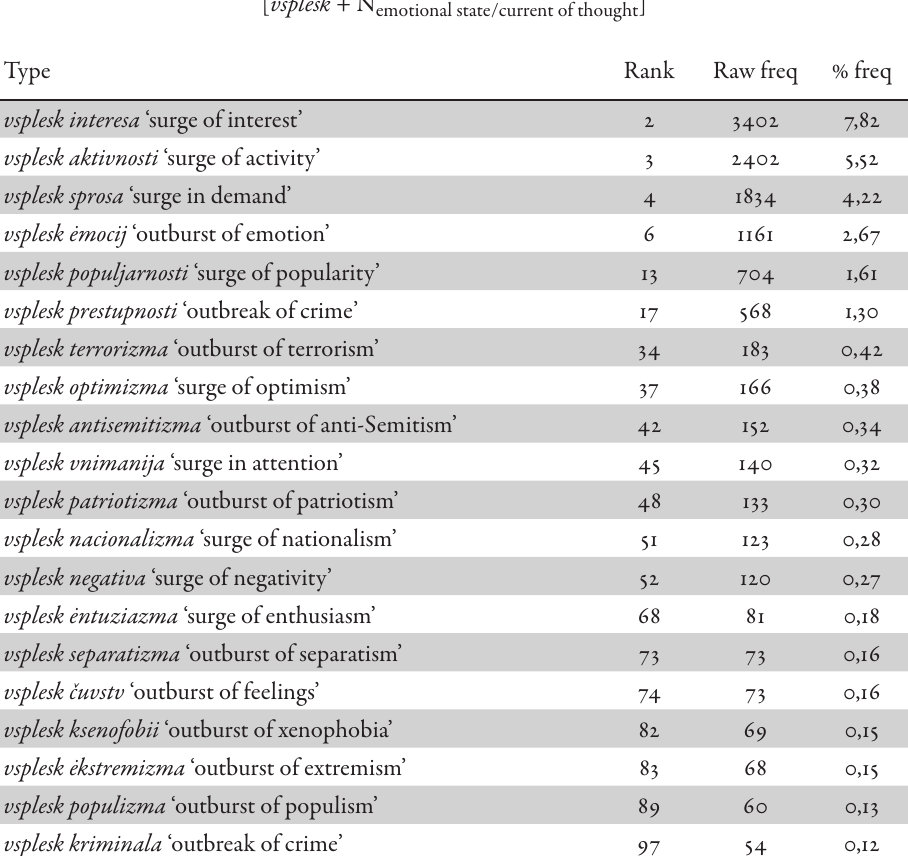
[ vsplesk + N emotional state/current of thought